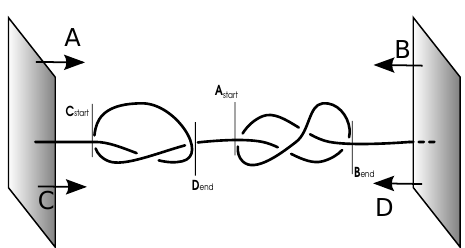
Figure 2. Knots detection. Schematic representation of the knot size analysis. We start by removing beads from the left-hand side (A). As soon as the Alexander polynomial indicates that we have neither composite nor 4 1 knot, the beginning of the 4 1 knot is reached ( A start ). By repeating this from the right-hand side (B), we get the end of the 4 1 knot ( B end ). Analogously, for the 3 1 knot, we start from the left-hand side again (C), but check for the Alexander polynomial to be neither composite nor 3 1 knot to get C start . Starting from the other side (D), D end is